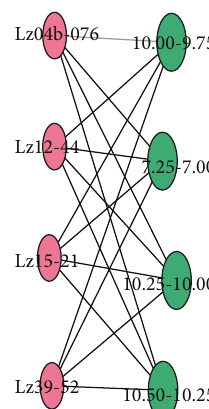
Figure 2: Construction process of the Sample/Grain-Size bipartite weighted network model.